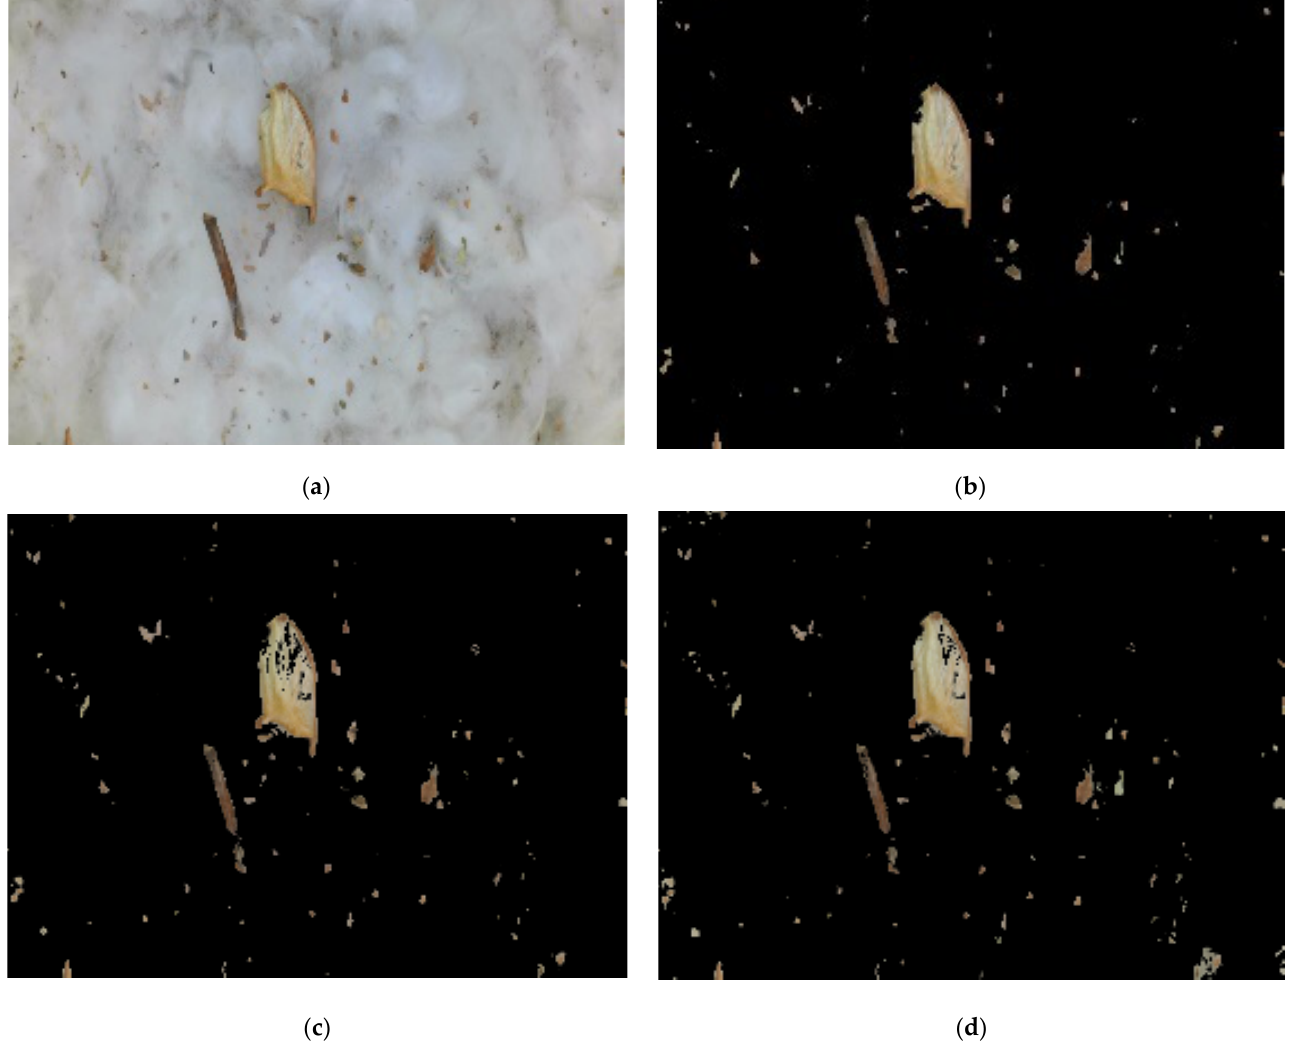
Figure 7. Comparison of the three segmentation methods. ( a ) The original image; ( b ) multi-channel fusion segmentation; ( c ) SVM segmentation; ( d ) k-means clustering segmentation.